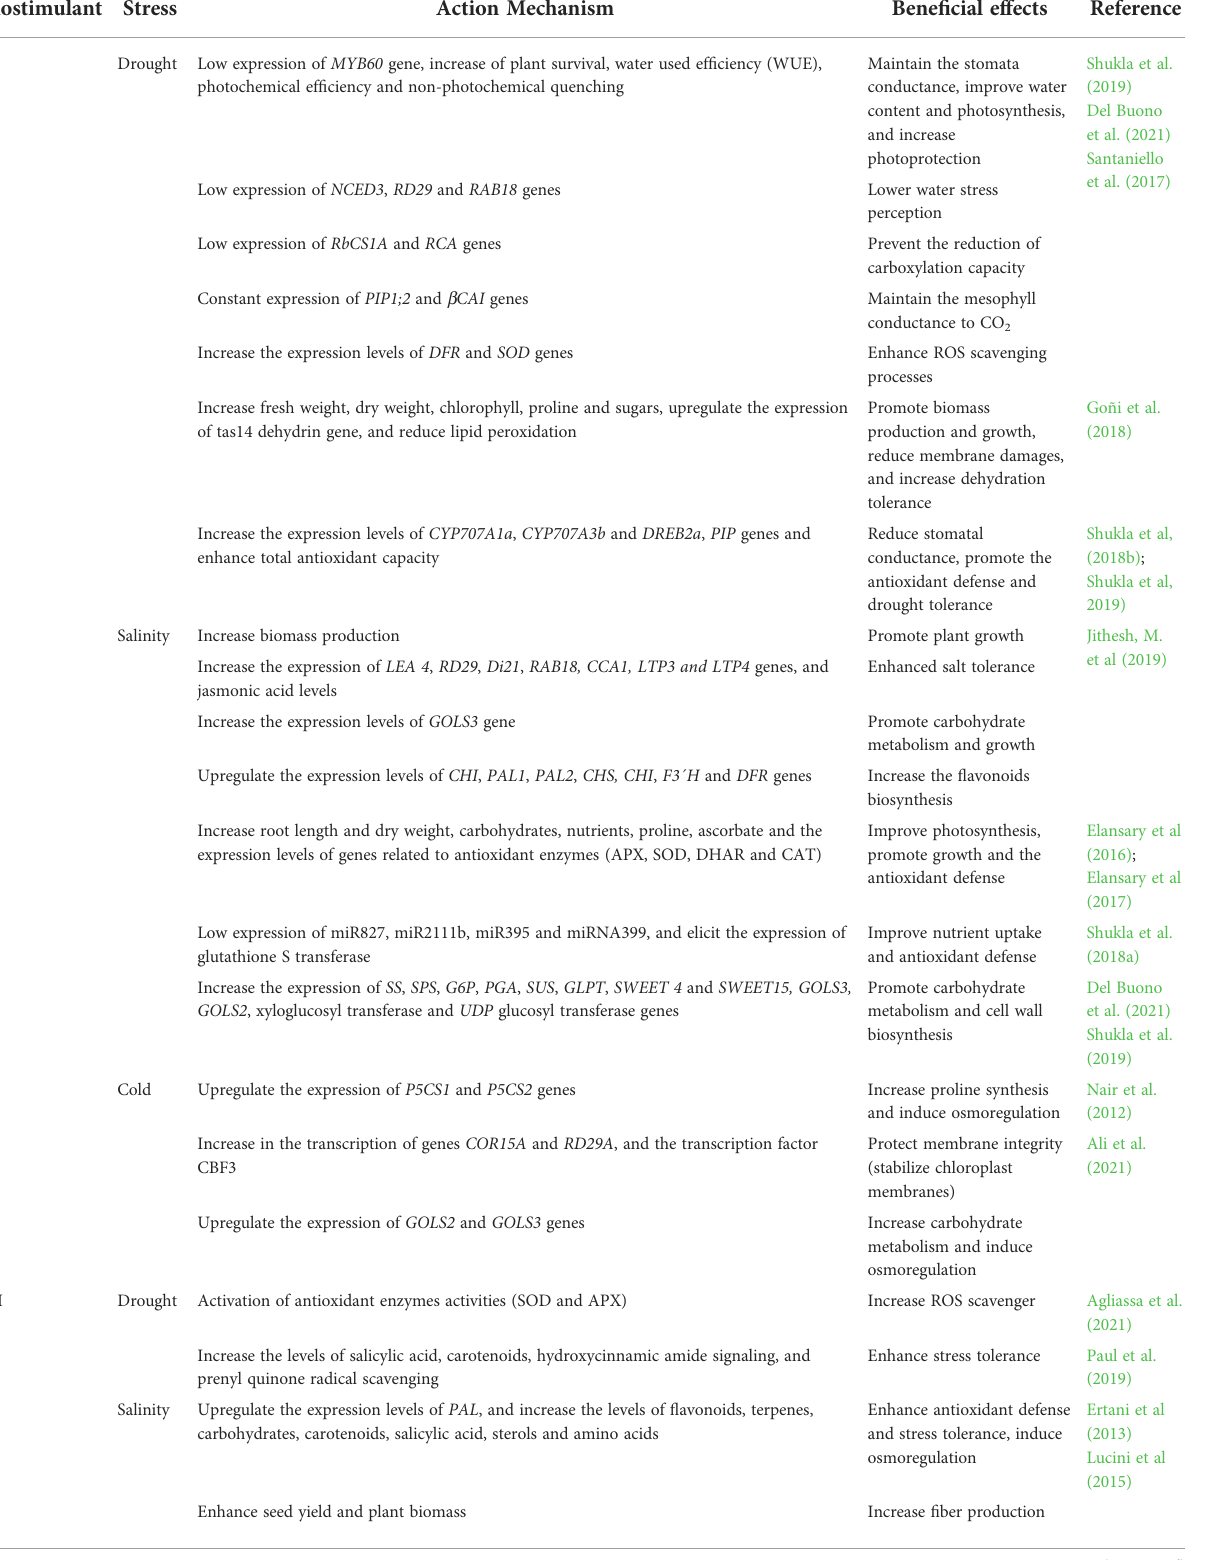
TABLE 1 Action mechanisms and bene fi cial effects of biostimulants (SE, seaweed; PH, protein hydrolysates; HS, humic substances; PGPB, plant growth promoting bacteria and AMF, arbuscular mycorrhizal fungi) in plants under drought, salinity, cold and heat